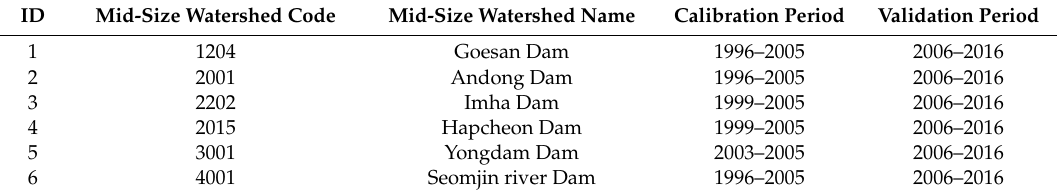
Table 2. Six representative dam list for the HSPF model calibration and validation.